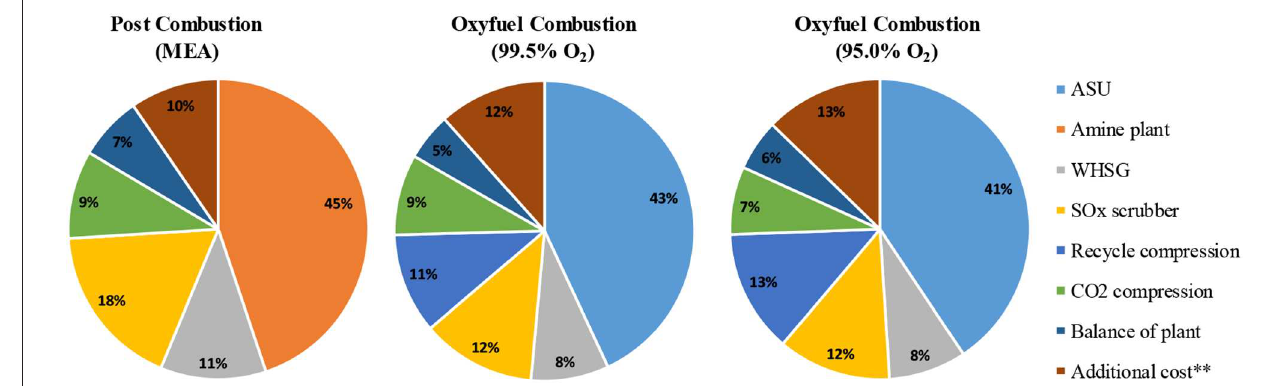
FIGURE 12 | Relative contribution of CO 2 capture technologies to total capital cost (**additional costs includes dehydration, home office engineering, insurance and profit), adapted from Mello et al. (2009a) with permission from